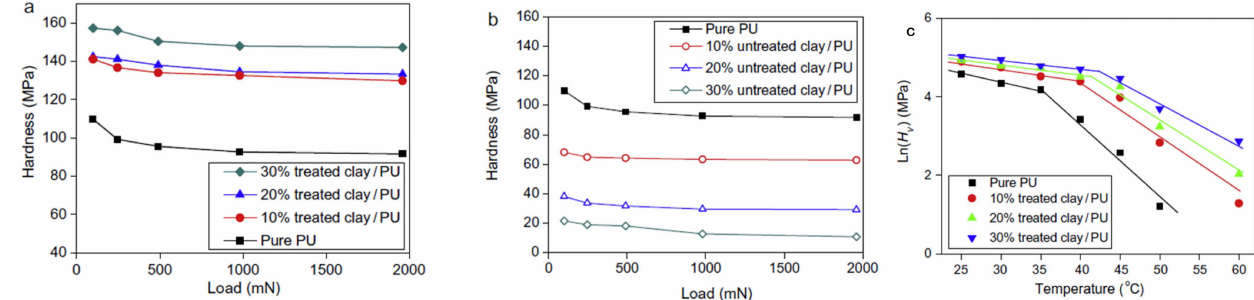
Figure 9. ( a ) Hardness of PU composites with treated clay, ( b ) Hardness of PU composites with untreated clay and ( c ) Microhardness vs. temperature of PU shape memory polymers. (Reproduced with permission from Elsevier,